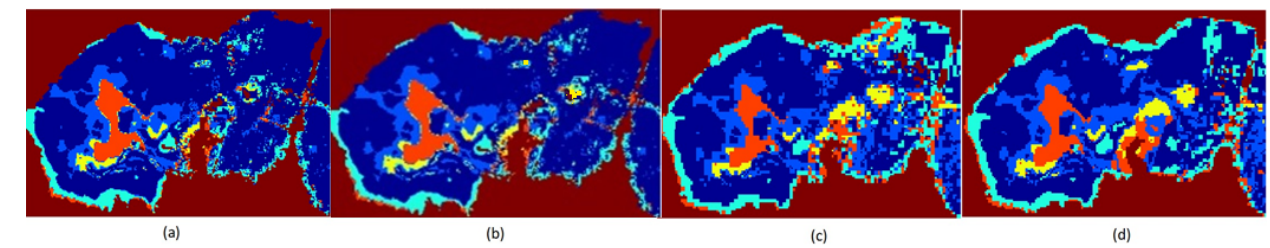
Figure 8. Subspace KNN Classified Image: (a) Sentinel-2 Case 1 (b) Sentinel-2 Case 2 (c) Landsat-8 Case 1 (d) Landsat-8 Case 2.